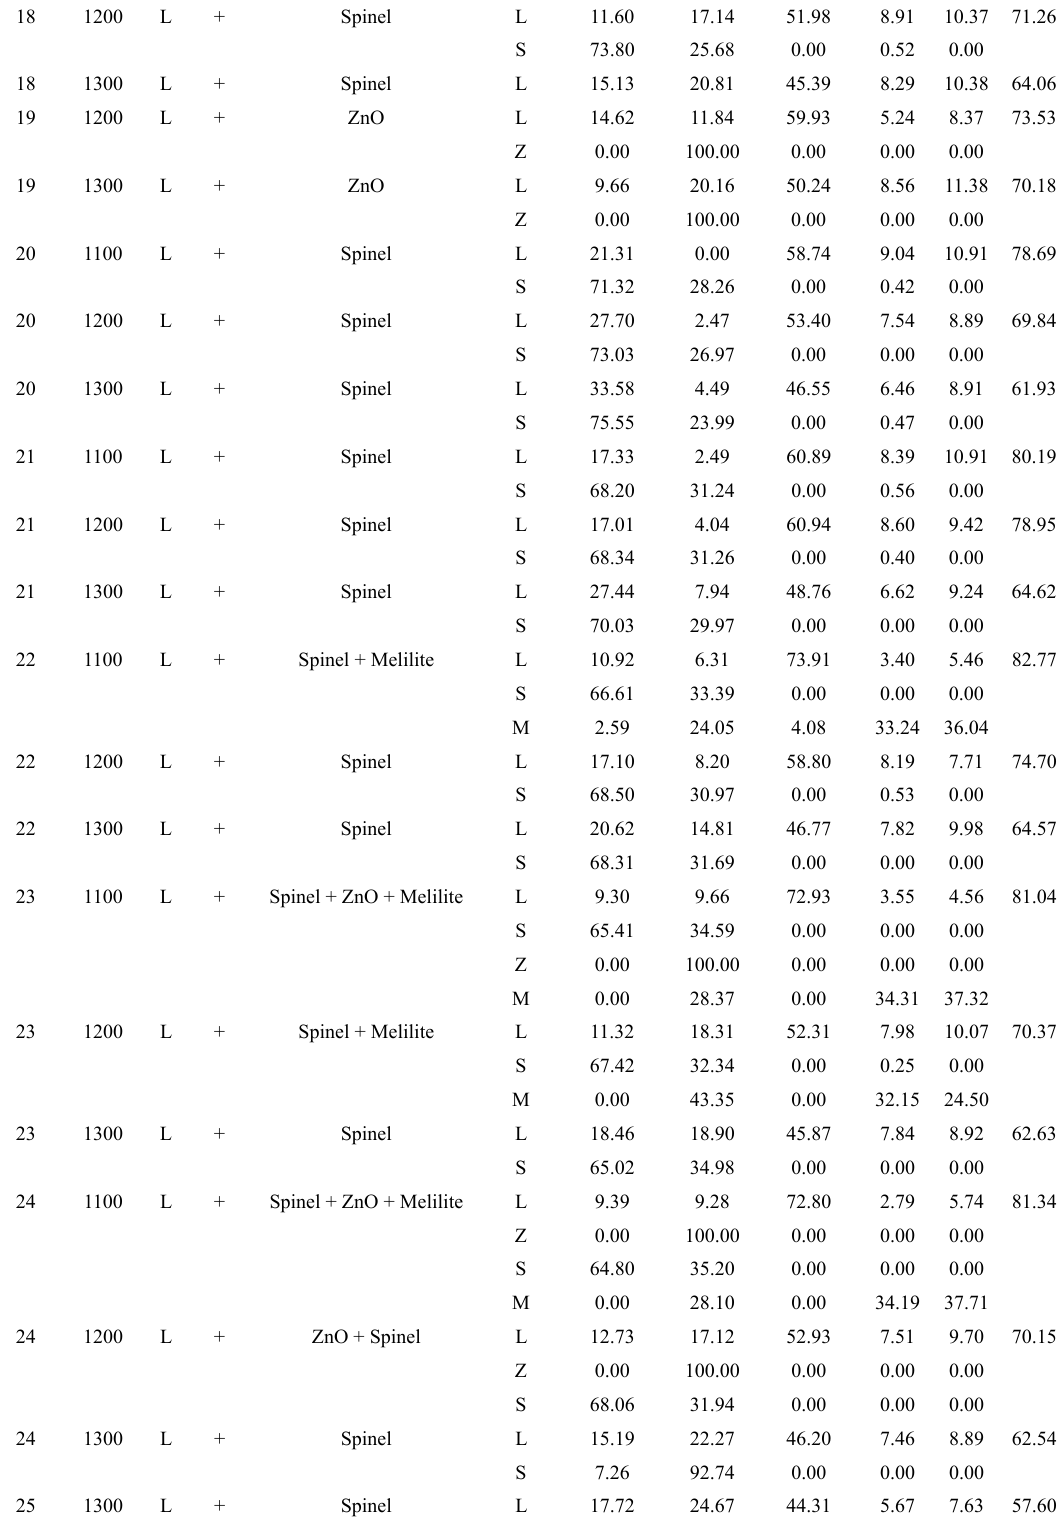
weight ratio of 1.1 and PbO/(CaO+SiO 2